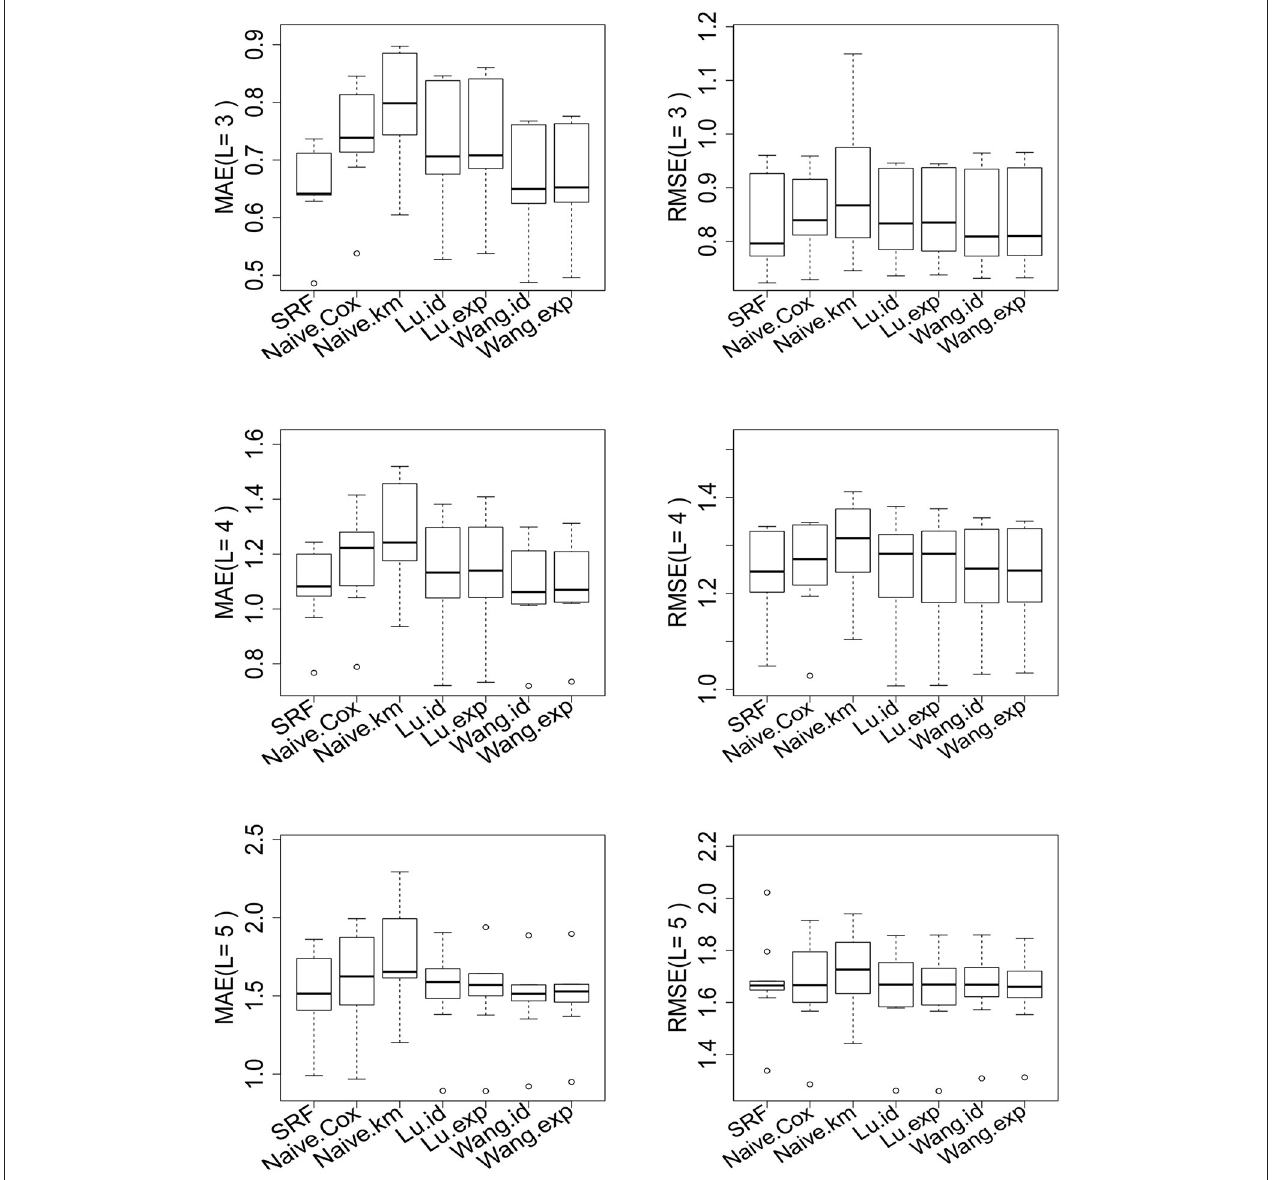
FIGURE 5 | Performance of the proposed random forest estimator compared with other methods for L = 3,4,5. The left penal is the MAE across of 10-fold cross-validation. The right panel is the RMSE across of 10-fold cross-validation. SRF, proposed random forest estimator; Naive.km, estimate based on Kaplan–Meier estimator without adjusting for the covariates; Naive.Cox, Cox regression based estimator; Lu.id, method of Tian et al. (2014) with identity link; Lu.exp, method of Tian et al. (2014) with exponential link; Wang.id method of Wang and Schaubel (2018) with identity link; Wang:exp, method of Wang and Schaubel (2018) with exponential